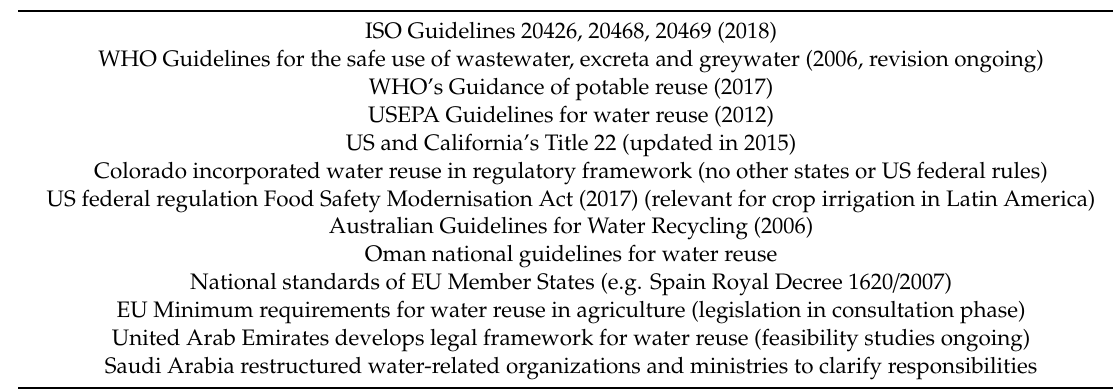
Table 1. Overview of existing and developing legislative frameworks of water reuse for industry, agriculture, or drinking